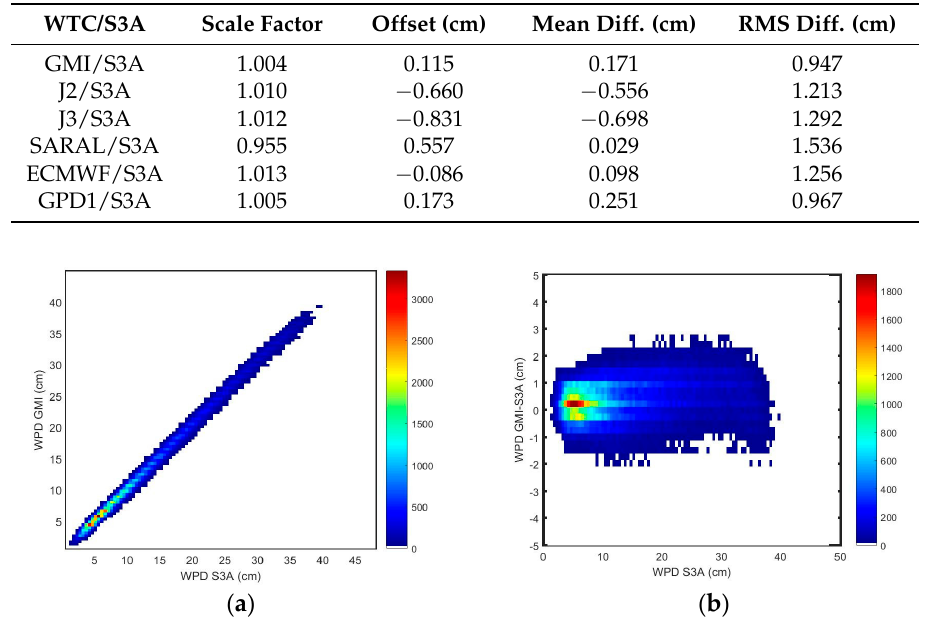
Figure 4. ( a ) Wet path delay from S3A versus WPD from the GMI; ( b ) WPD from S3A versus WPD differences between the GMI and S3A (~219,000 points). differences between the GMI and S3A (~219,000